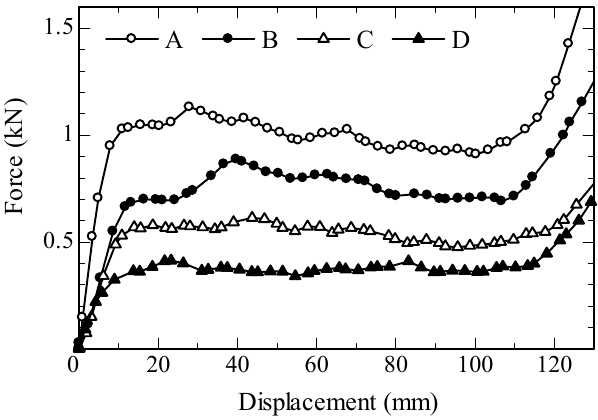
Figure 7. Force vs. piston displacement curves obtained in ram-extrusion